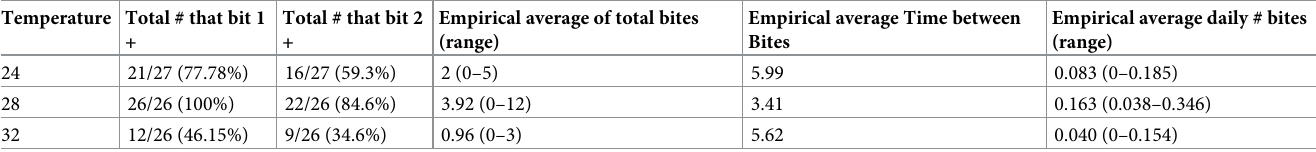
Table 2. Summary metrics of biting profiles at each